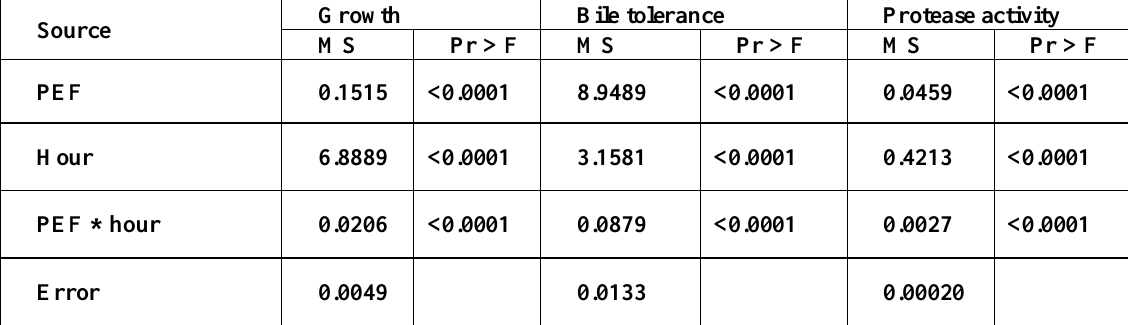
Table 4: Least square means for growth, bile tolerance and protease activity of Lactobacillus delbrueckii ssp. bulgaricus LB-12 as influenced by mild pulsed electric field. Treatment